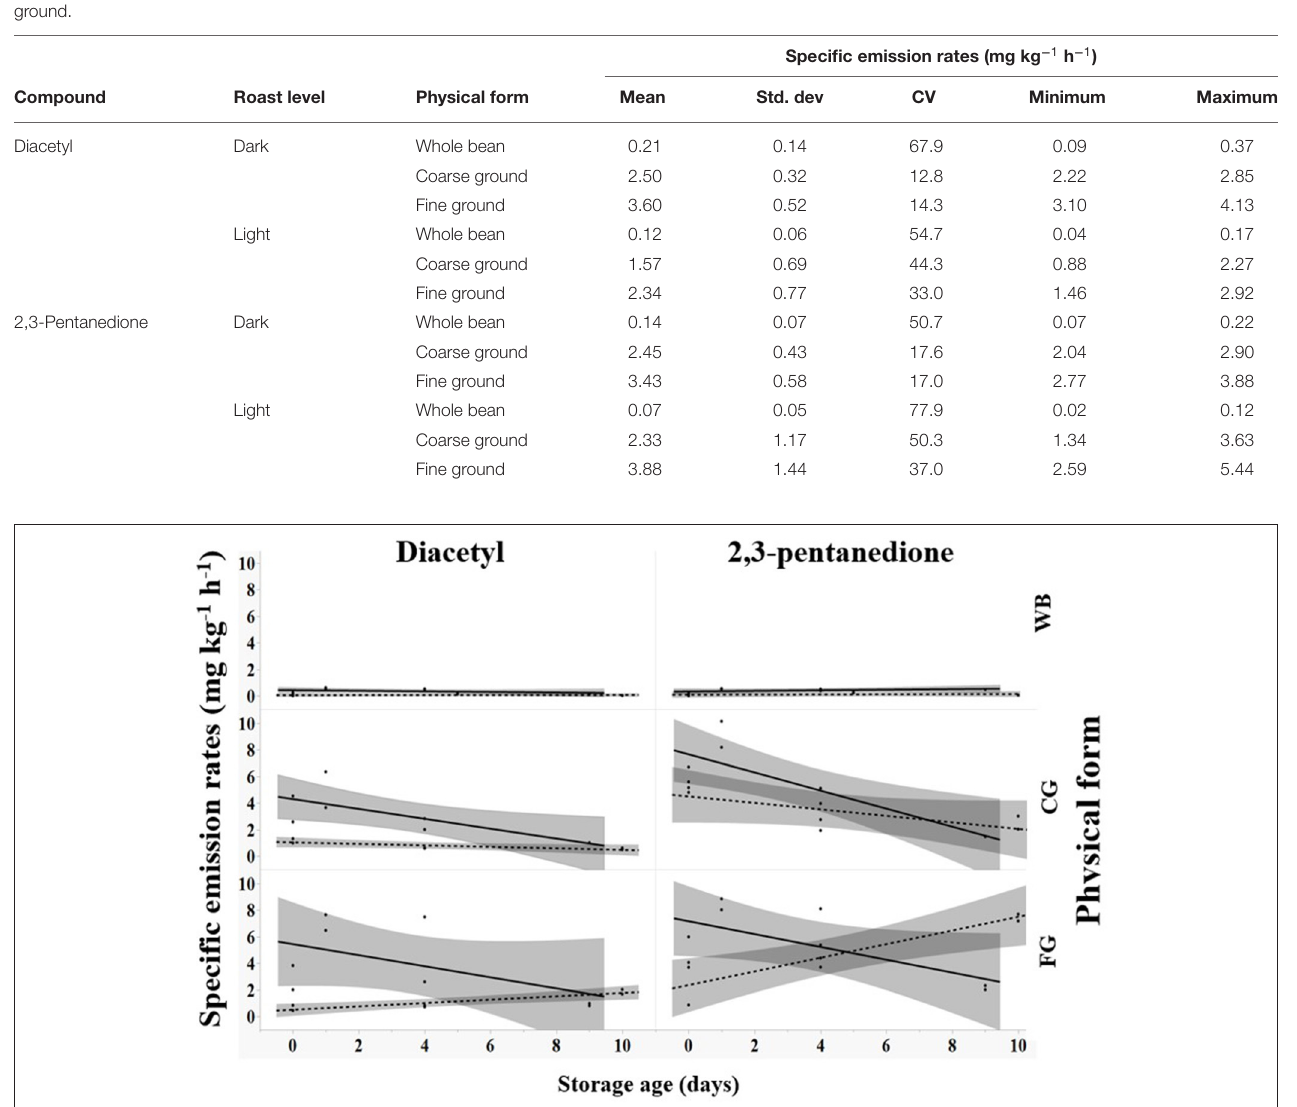
FIGURE 2 | Effect of storage age (days) on specific emission rates for diacetyl and 2,3-pentanedione for different roast levels (— dark, - - - light) and forms of roasted coffee including whole bean (WB), coarse ground (CG), and fine ground (FG). Shaded areas around lines indicates 95% confidence limit of least-squares regression